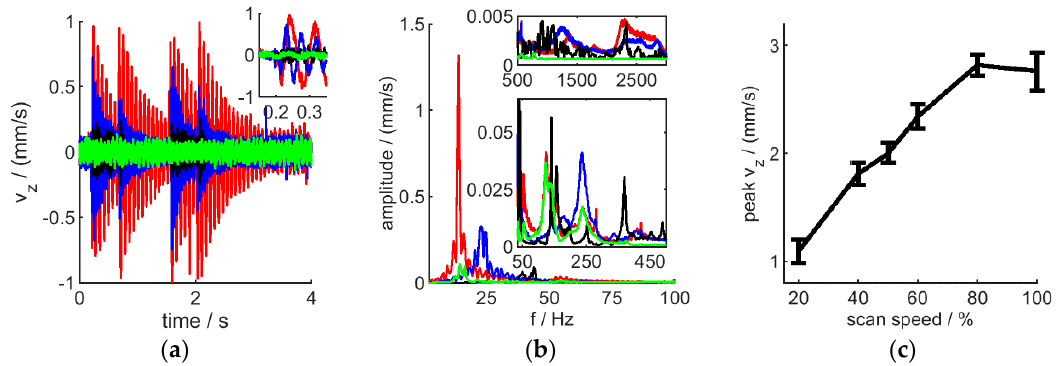
Figure 14. Measurement-induced vibrations. Velocity-traces ( a ) and dominant frequency components ( b ) are shown for H6 mounted on H-frame and measuring, (black); H6 inactive, on fully extended robot arm (green); H6 measuring, on fully extended robot arm (red); H6 measuring, on compact-pose robot arm (blue). Inset: zoom on first vibration cycles. ( c ): Vibration velocity peak values in function of interferometer scan speed. Error-bars represent the standard deviation of 11 repeated measurements.